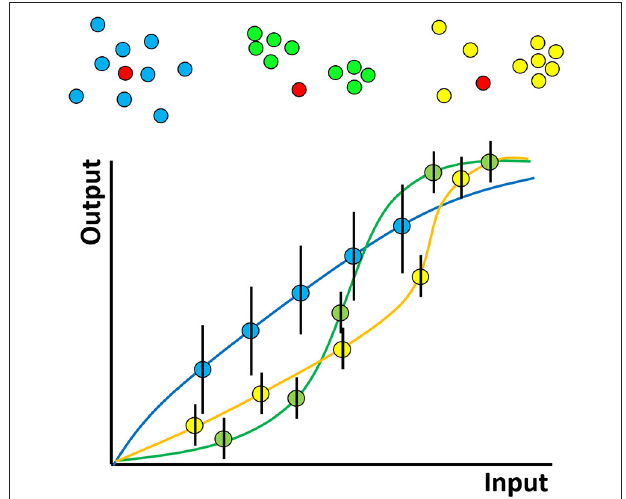
FIGURE 2 | Hypothesized effect of molecular nanoclustering on input-output relationship of a generalized signaling pathway for two proteins. A hypothetical kinase for example (red) can diffuse in the membrane and phosphorylate a substrate with different clustering properties (blue, green, yellow). The input can be conceptualized simply—as the amount of active kinase or more generally—say as the strength of antigen binding by a receptor. The output might be proximal downstream phosphorylation levels more distal, such as gene expression—analogous to the rate of production of product in a chemical reaction. The shape of the curve relating these two depends on the stoichiometry, oligermerisation and cooperativity of the molecules involved, just like a classical chemical reaction. In a cell signaling pathway however the situation will be complex, with many interacting partners, feedback and so on. The exact shapes of such hypothetical curves therefore remain an area for future